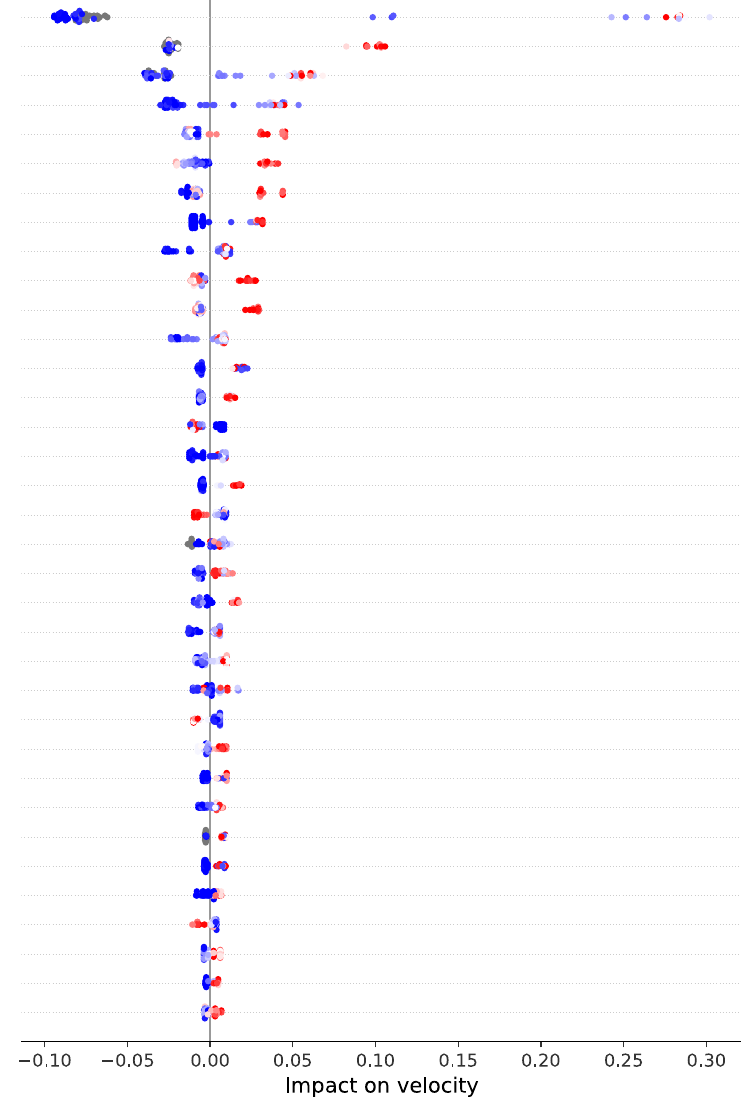
Fig 41. (Color online) summary plot showing how each factor contributes to increase/decrease velocity at the peak of acceleration.